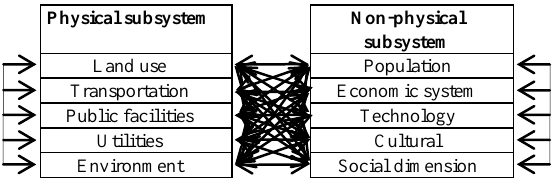
Figure 1: Wicked problems and its associated